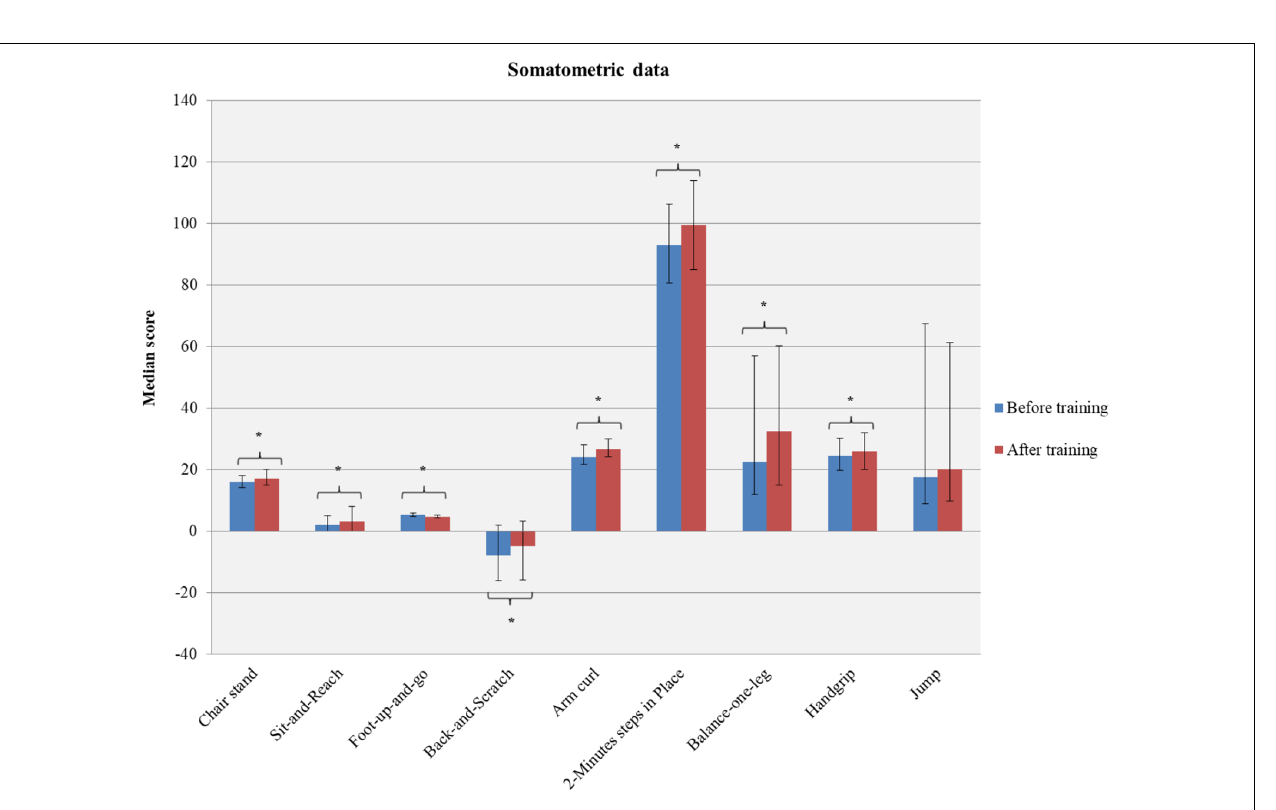
FIGURE 2 | A summary of intervention-induced changes in different physical fitness components. ∗ indicates the significant improvement in the participants of these tests after the dance